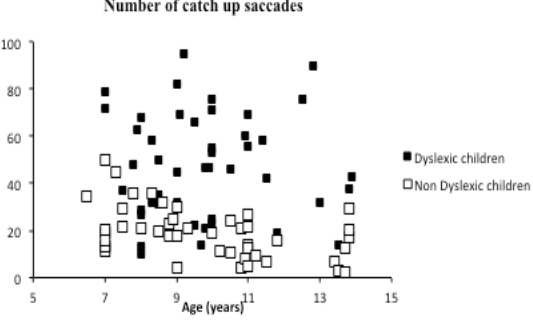
Figure 3. Number of catch-up saccades measured during pur- suits for dyslexic and non-dyslexic children examined.